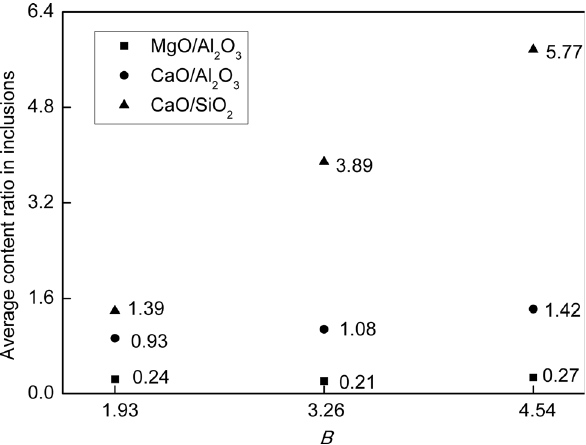
Figure 5 : The relationship between average content ratio of inclusions and slag